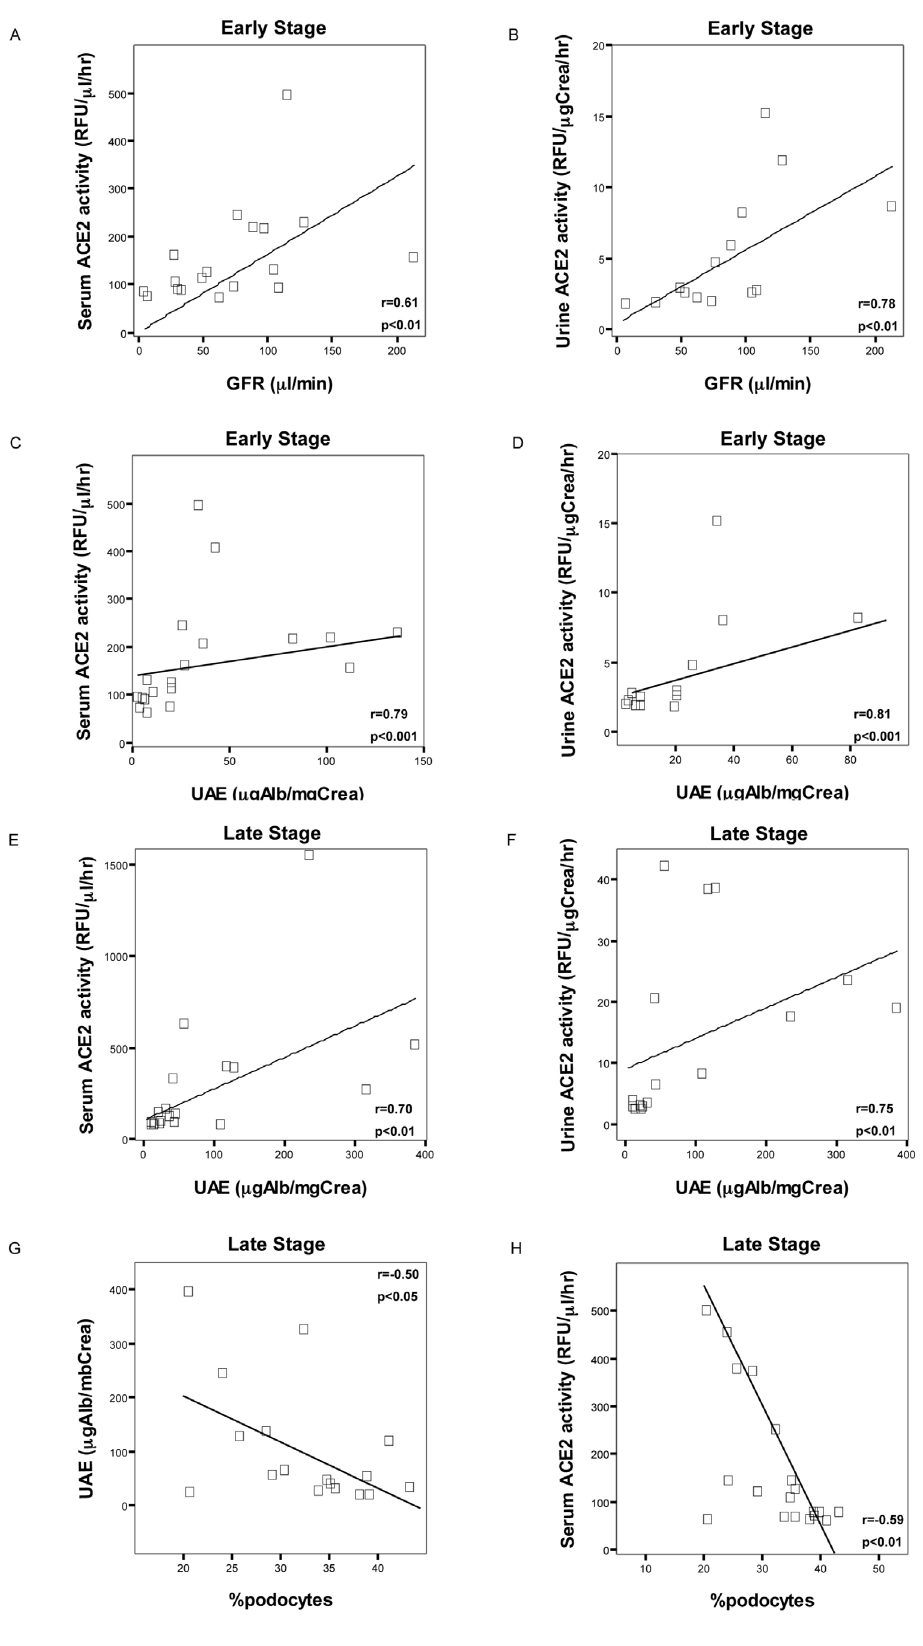
Figure 4. Correlation between serum and urine ACE2 and kidney function parameters. ACE2 activity in serum (A) and urine (B) directly correlated with glomerular filtration rate in early stage of non-treated non-obese diabetic mice (Diabetic), NOD-insulin treated mice (Diabetic + INS)